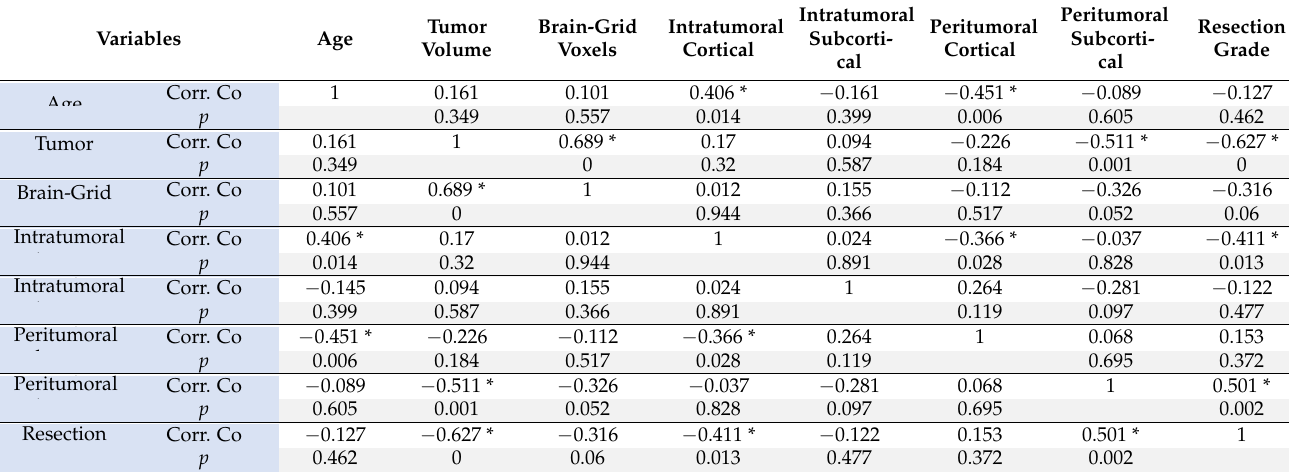
Table 3. Summary of the Spearman’s correlation analysis for numeric and continuous variables. The distribution of intraoperative eloquent spots was not normally distributed (Shapiro–Wilk test p < 0.001) and therefore a nonparametric test was chosen for the correlation analysis.